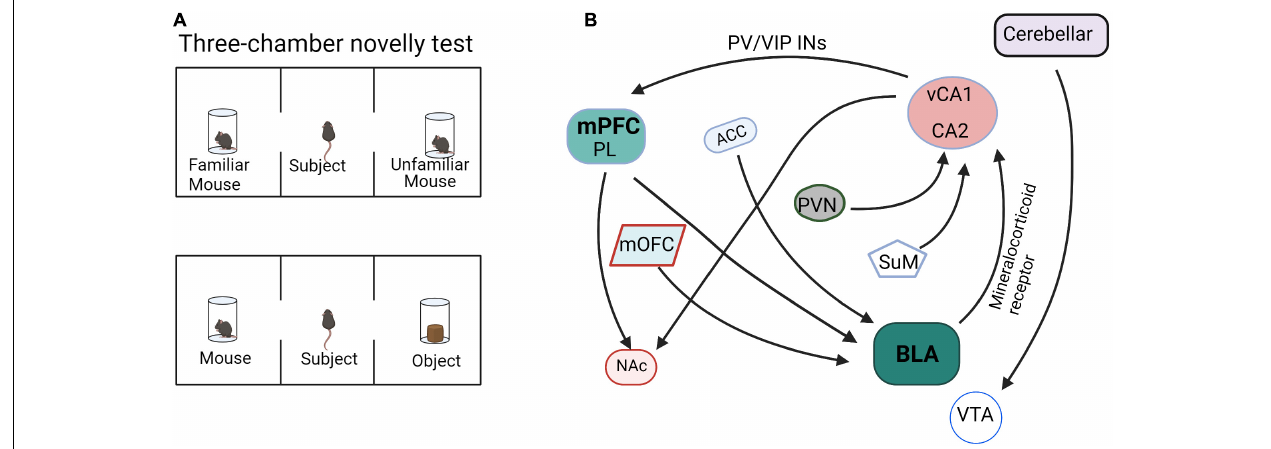
FIGURE 2 | Functional connectivity within the social memory and preference circuits. (A) The paradigm diagrams of social memory and preference behaviors. (B) The neural circuits of social memory and preference. mPFC, medial prefrontal cortex; PL, prelimbic cortex; HPC, hippocampus; BLA, basolateral amygdala; mOFC, medial orbitofrontal cortex; NAc, nucleus accumbens; PVN, paraventricular nucleus; ACC, anterior cingulate cortex; SuM, supramammillary nucleus; VTA, ventral tegmental area.